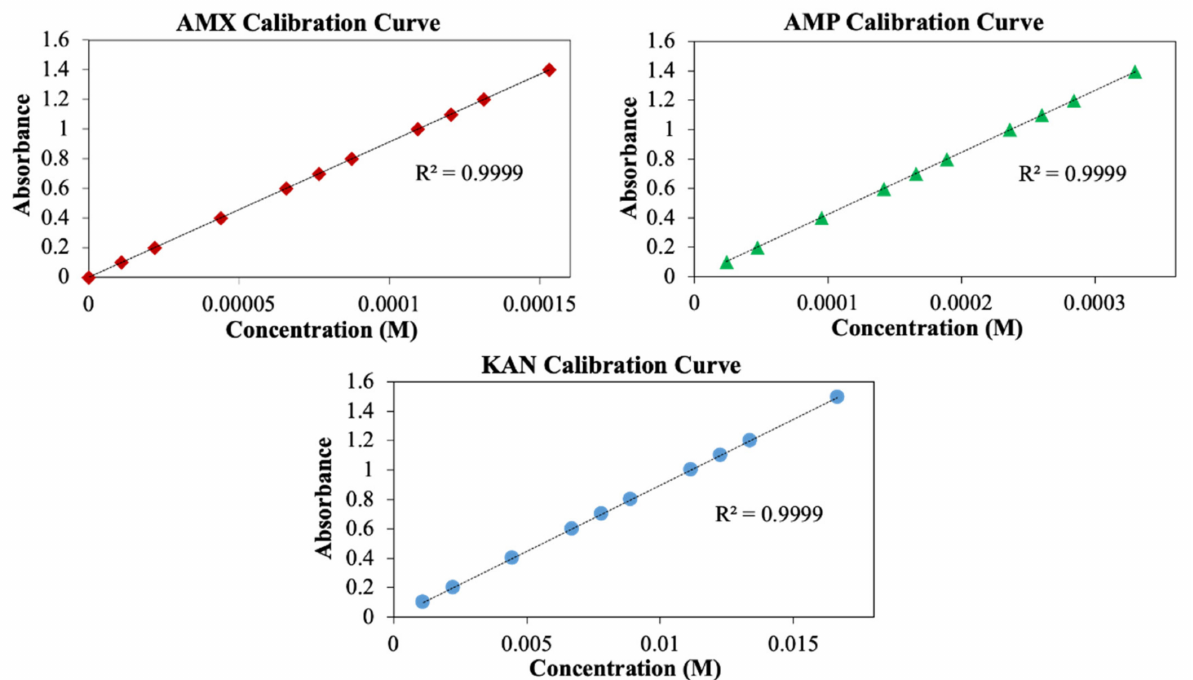
Figure 7. Calibration curves for AMX, AMP, and KAN drugs.